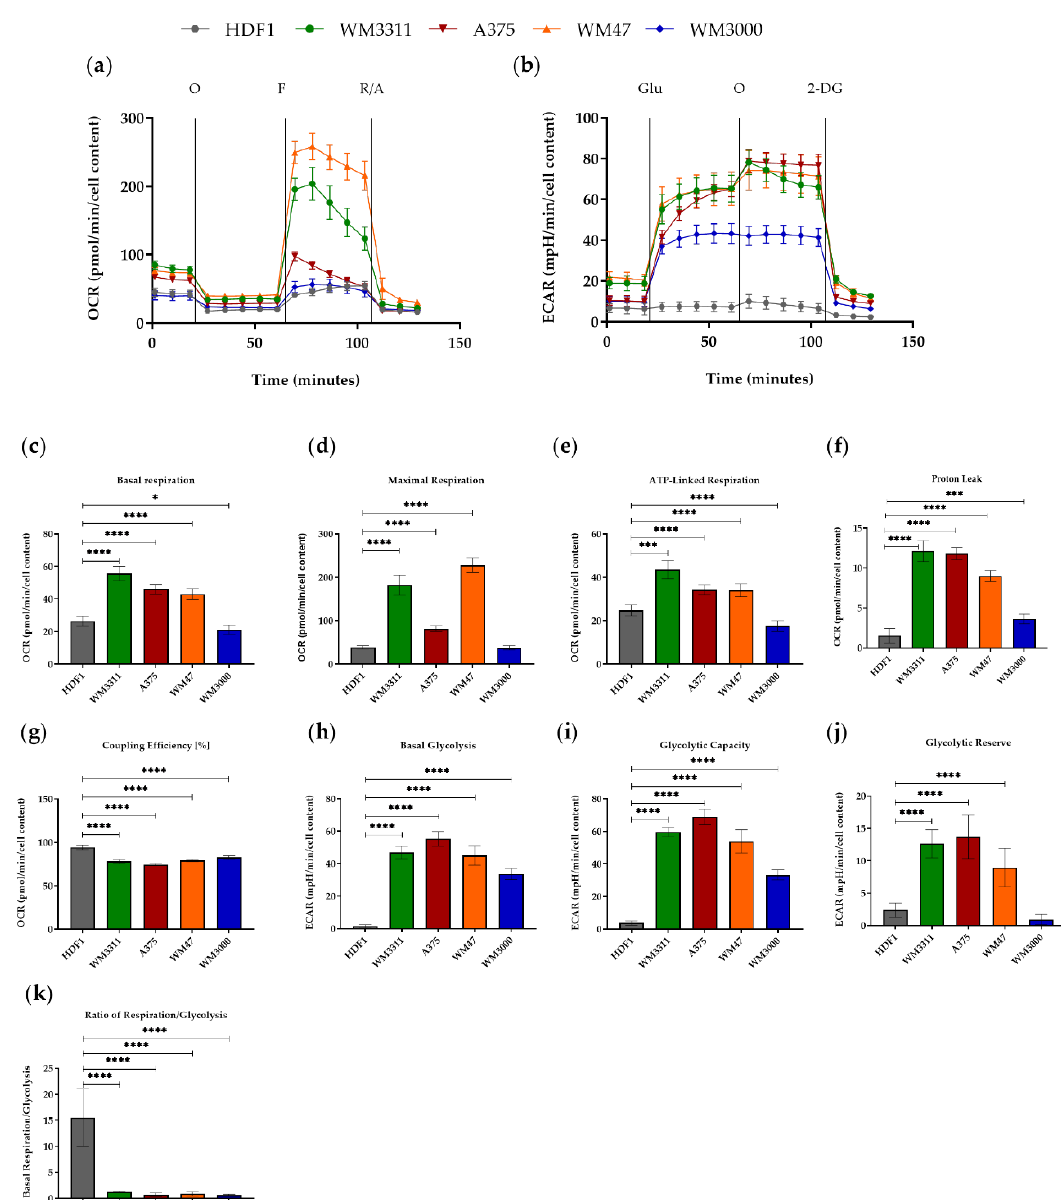
Figure 2. Results of the Mito Stress ( a ) and Glycolysis Stress ( b ) tests in HDF1, WM3311, A375, WM47 and WM3000 cells are presented as real-time measurements of OCR. ( c ) Basal respiration, ( d ) maximal respiration, ( e ) ATP-linked respiration, ( f ) proton leak, ( g ) coupling efficiency %, ( h ) basal glycolysis, ( i ) glycolytic capacity, ( j ) glycolytic reverse, ( k ) ratio of respiration to glycolysis. Values are given as mean ± SD. One-way ANOVA followed by Dunnett’s Multiple Comparison Test; * p ≤ 0.05; *** p ≤ 0.001; **** p ≤ 0.0001. For every cell line, two independent measurements with 6 to 8 replicates were performed. 10 mM Glucose (Glu); 5 µM Oligomycin (O); 2 µM FCCP (F); 0.5 µM Rotenone and Antimycin A (R/A); 50 mM 2-Deoxy-d-glucose (2DG).